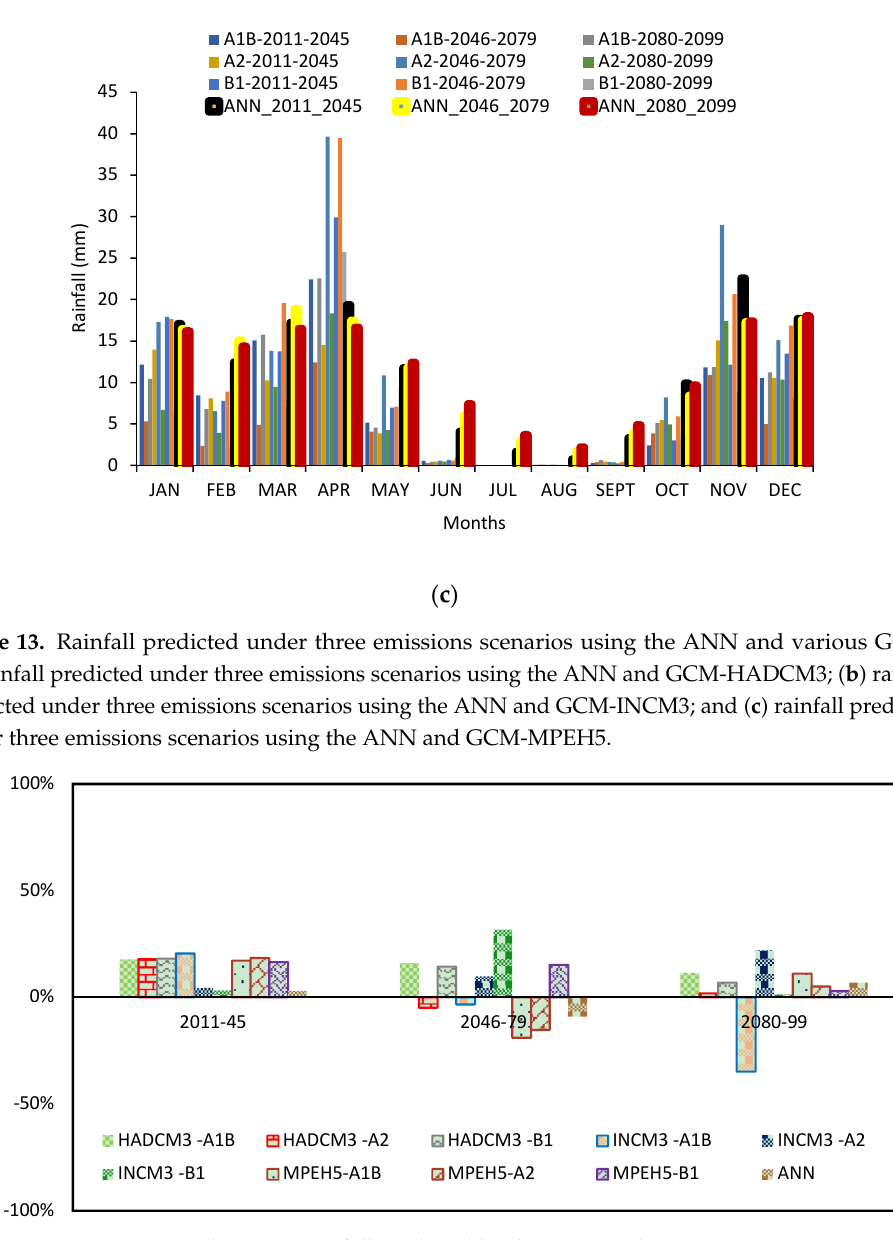
Figure 14. Change in rainfall predicted by the ANN and various GCMs.